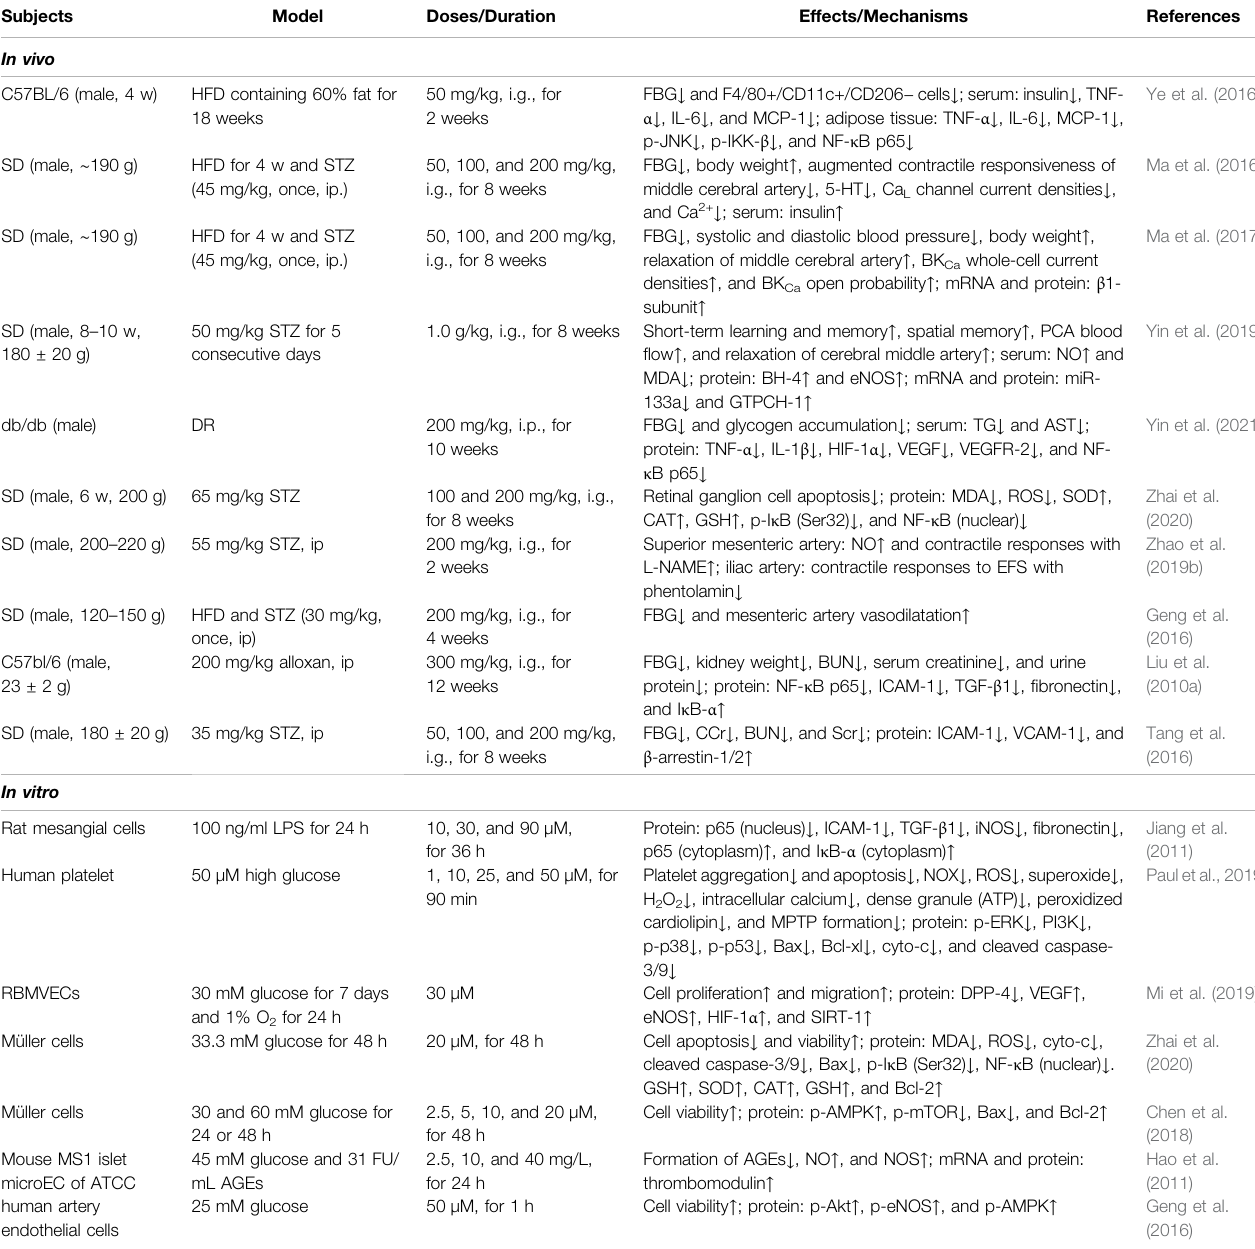
TABLE 5 | The in vivo and in vitro mechanism of berberine in the treatment of DM and its